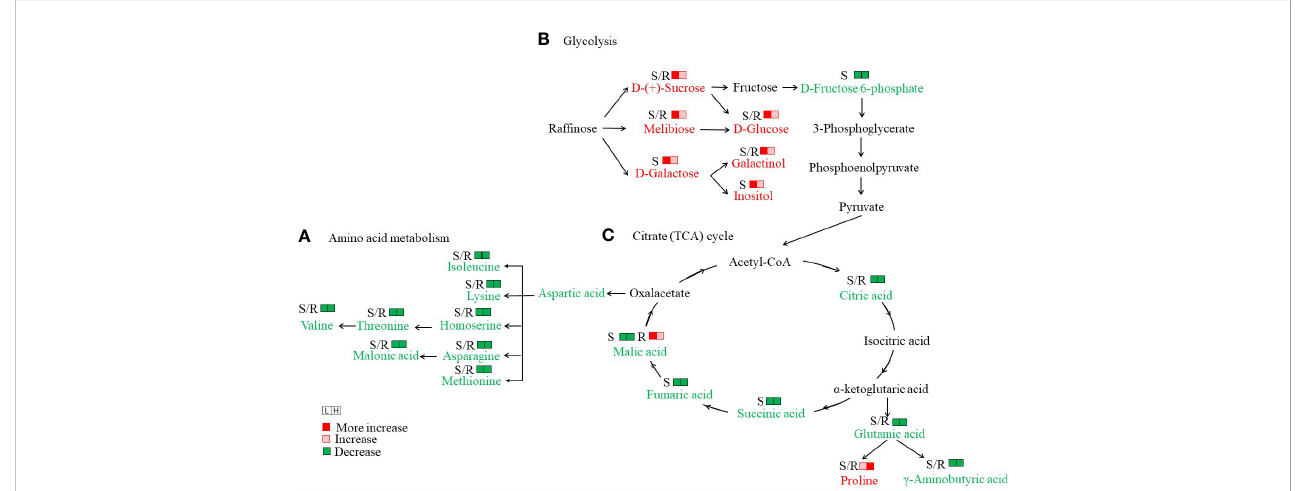
FIGURE 5 Analysis of important metabolic networks in the seedlings of Salicornia europaea under different NaCl conditions. (A) Amino acid metabolism, (B) Glycolysis, and (C) Citrate (TCA) cycle. S/R, shoot or root. The metabolites with a red color indicate an increase under both L (50 mM NaCl) and H (300 mM NaCl) conditions compared with CK (0 mM NaCl), while the metabolites with a green color indicate decreases under both L and H conditions compared with